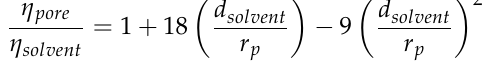
Figure 2. Schematic representation of a solvent drop on membrane surface with different degree of hydrophobicity. ( a ) Hydrophilic membrane and polar solvent or Hydrophobic membrane and apolar solvent; ( b ) Semi-Hydrophilic membrane and polar solvent and ( c ) Hydrophilic membrane and apolar solvent or Hydrophobic membrane and polar solvent.